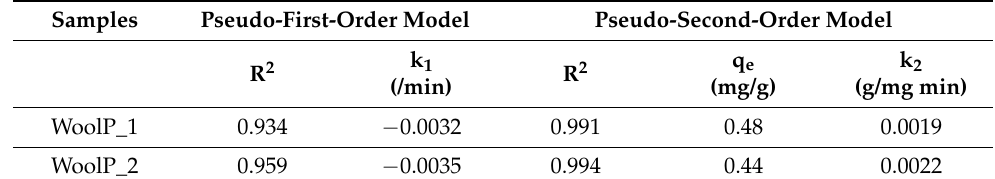
Table 3. Kinetic parameters for the two dyeing processes WoolP_1 and WoolP_2.